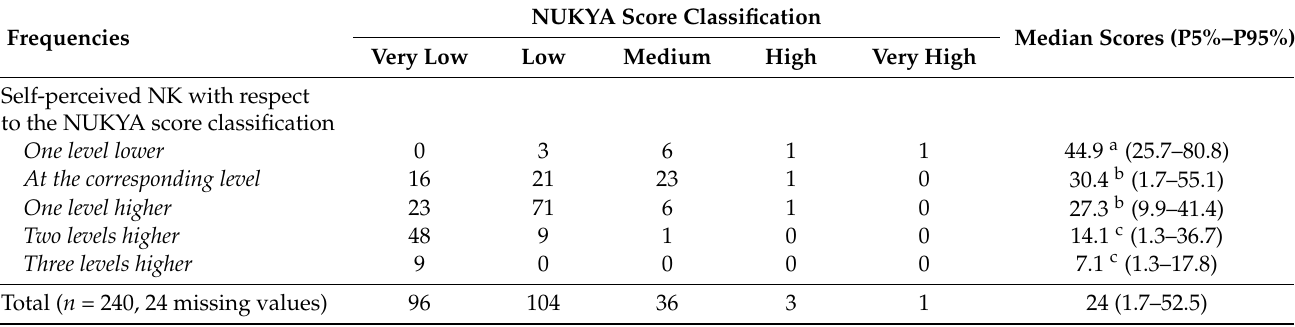
Table 4. Distribution of the deviation of the athletes self-perceived level of NK in relation to the NUKYA score classification. The last column includes the median of the NUKYA score for each group of athletes in the row. Different superscript letters indicate statistically significant differences in median scores ( p <